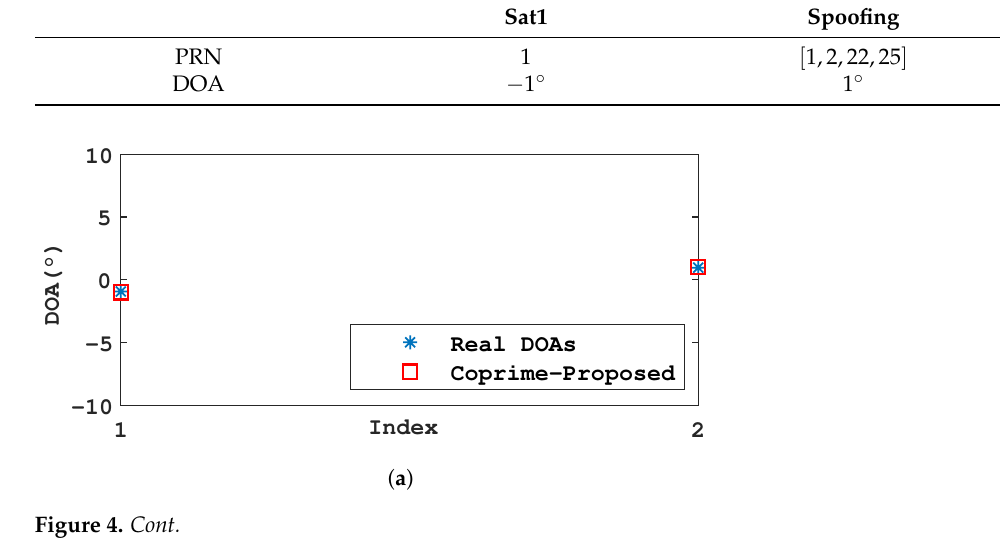
Table 3. Simulation parameters of incident sources in Section 4.2.